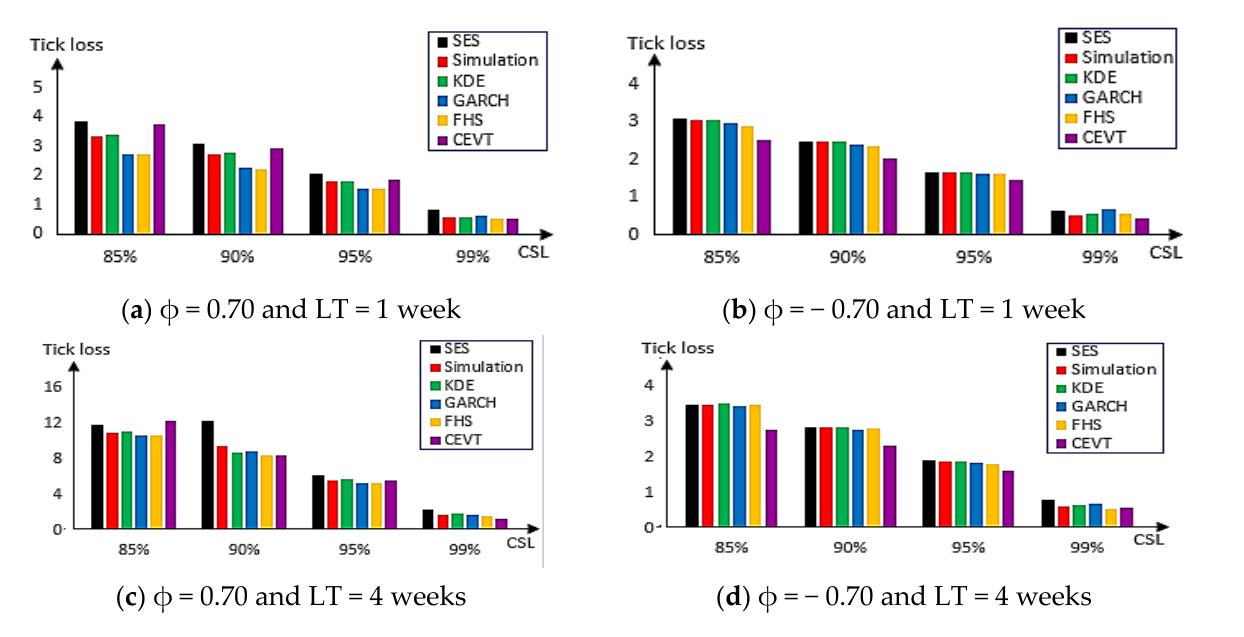
Figure 7 plotted the backorders versus inventory investment. Each curve for each panel contained four specific points corresponding to the four targets CSL (85%, 90%, 95% and 99%). We can see in the case of ϕ = − 0.70 that the CEVT method gives good results in terms of inventory investment and backorders for CSL targets 85%, 90% and 95%. The 99% level provides a lower level of backorders but does not give the minimum inventory investment. Therefore, it is difficult to determine the best method. We can also see in the case of ϕ = 0.70 that the GARCH method provides results with the FHS, notably for lead times of one week.